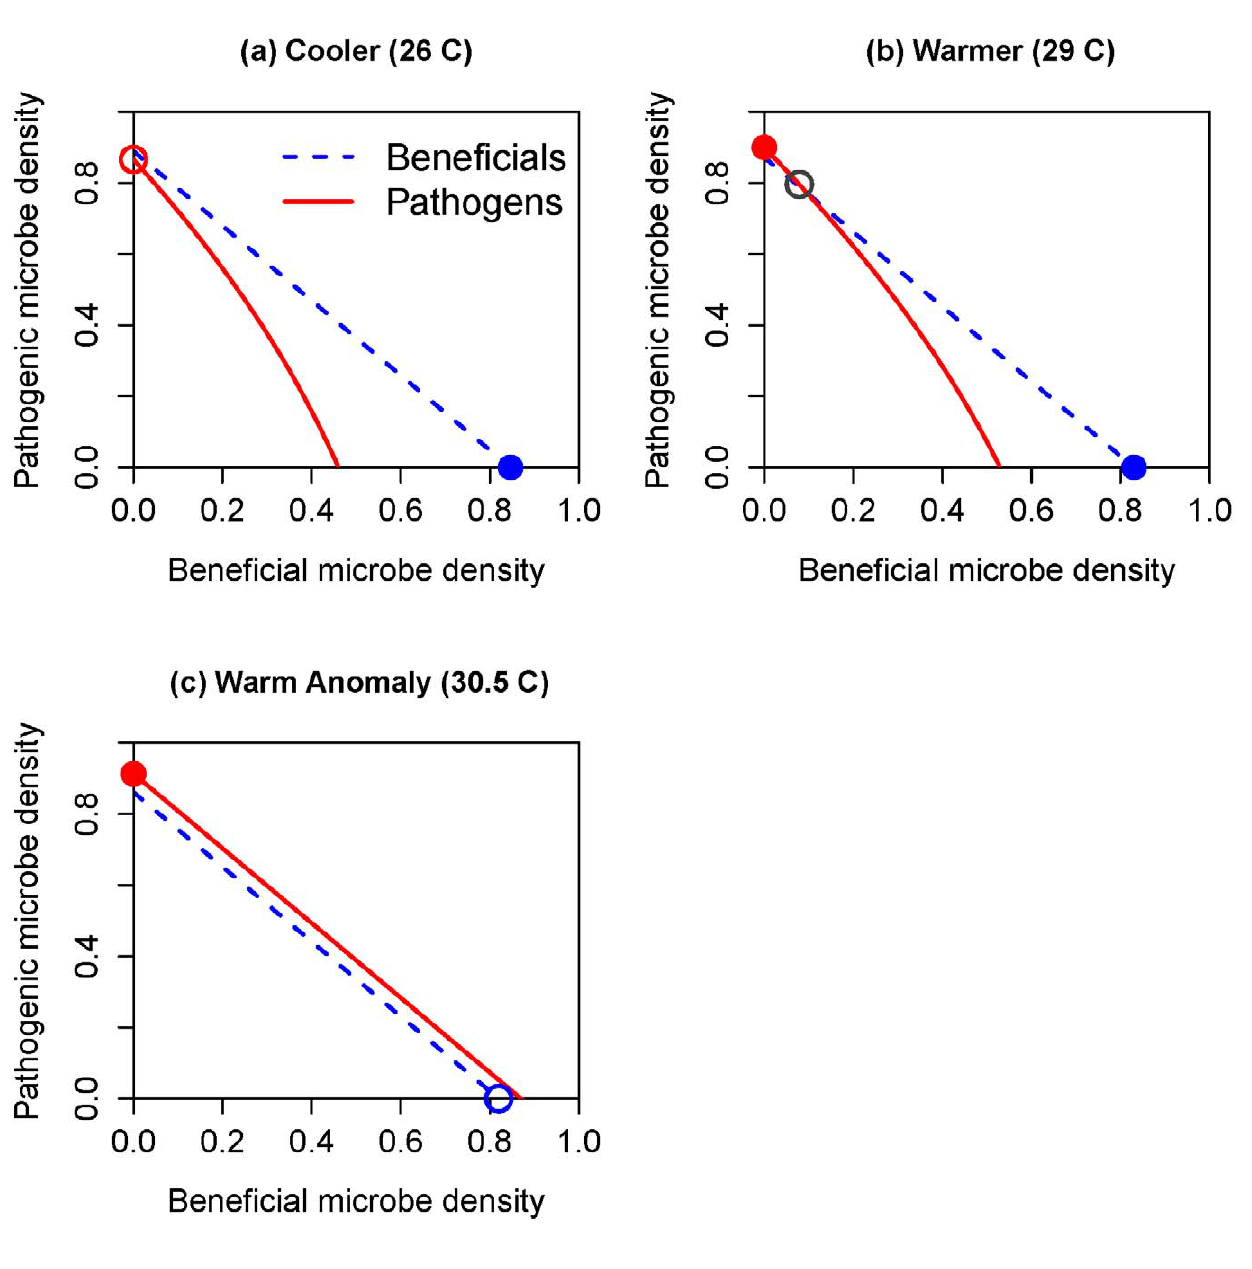
Figure 2. Nullclines (solid red = pathogens, dashed blue = beneficials) of the well-mixed SMC model (Equation (8)), for the parameter values such that a brief thermal anomaly allows pathogens to become dominant (the slower baseline parameters in Table 1). Panel (A) shows conditions in winter, when the beneficial-dominant equilibrium is stable (solid circle) while the pathogen-dominant equilibrium is unstable (open circle). Panel (B) shows conditions in summer, when the beneficial-dominant and pathogen-dominant equilibria are both stable (solid circles), while the coexistence equilibrium (open circle) is unstable. Panel (C) shows the effect of a small increase in temperature that eliminates antibiotic activity, so that the nullclines of pathogen and beneficial bacteria become parallel. The beneficial-dominated equilibrium (open circle) becomes unstable, so the community converges to the pathogen-dominated equilibrium (solid circle).